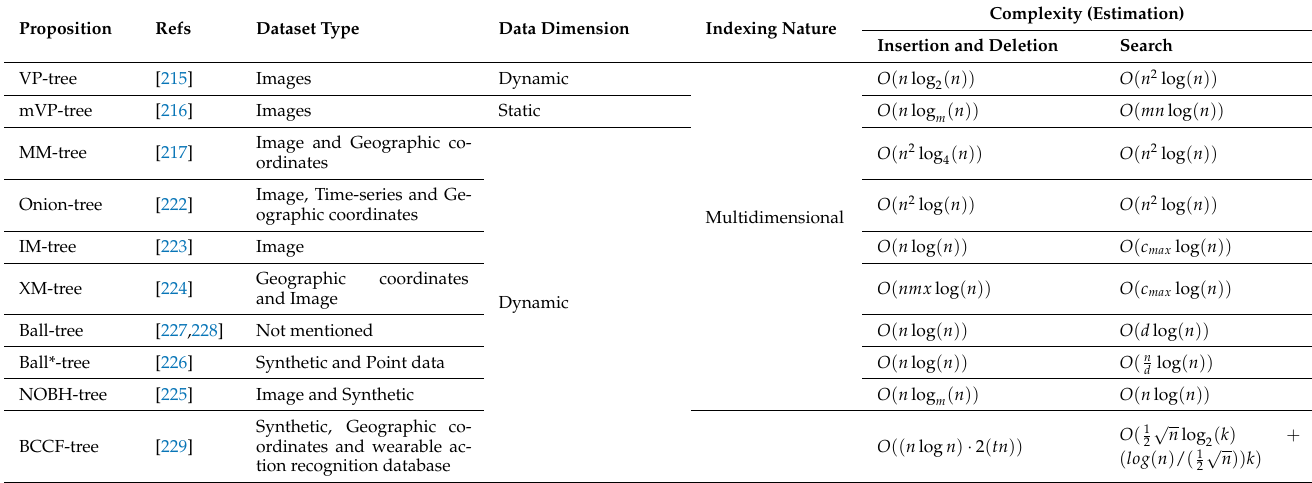
Table 11. Analysis of metric indexing techniques based on ball